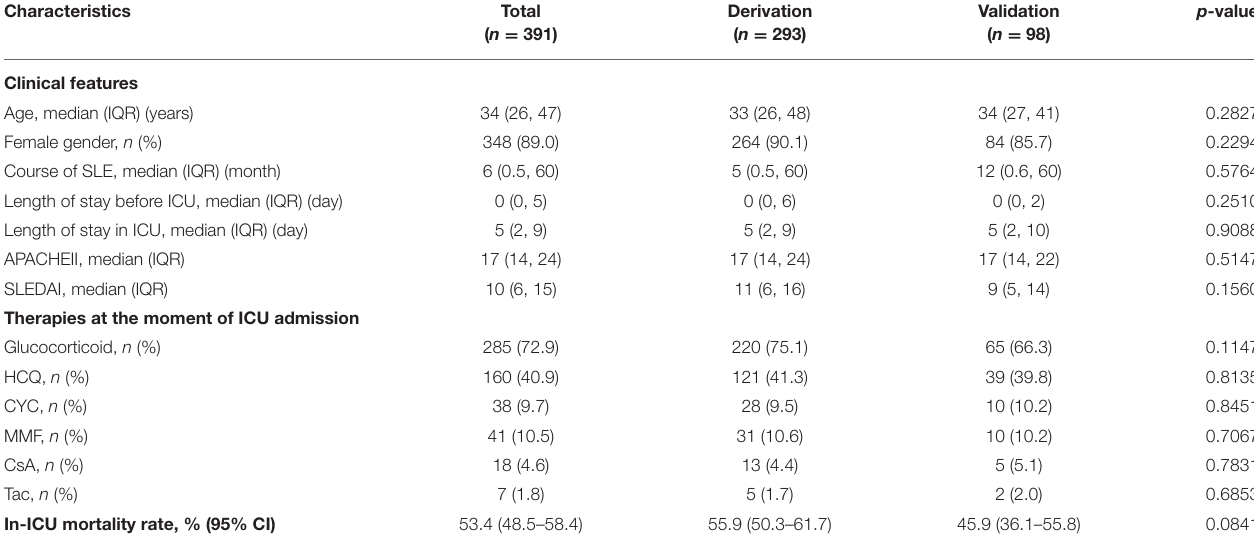
TABLE 1 | General characteristics of the 391 patients. Characteristics